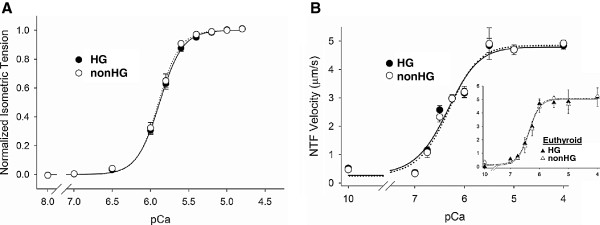
Thin filament characteristics and myofilament performance.A. Normalized isometric tension-calcium relationships of HG and nonHG controls were not different from each other, indicating similar thin filament sensitivities to calcium activation. B. Native thin filament (NTF) velocity-calcium relationships detected using the myosin motility assay were also similar between HG and nonHG demonstrating similar calcium sensitivity and myosin-actin MgATPase activity. Inset illustrates that HG did not affect NTF function in euthyroid rats not PTU-treated.